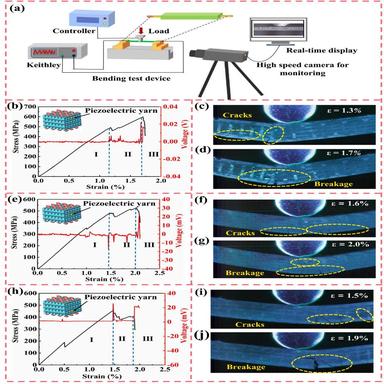
Establish the static three-point bending test and the response relationship of the electrical signal. (a) A schematic diagram of a three-point bending test and an electrical signal test equipment. (b–j) 3DOPC stress-strain and electrical signal curves and failure morphology process under static three-point bending test.